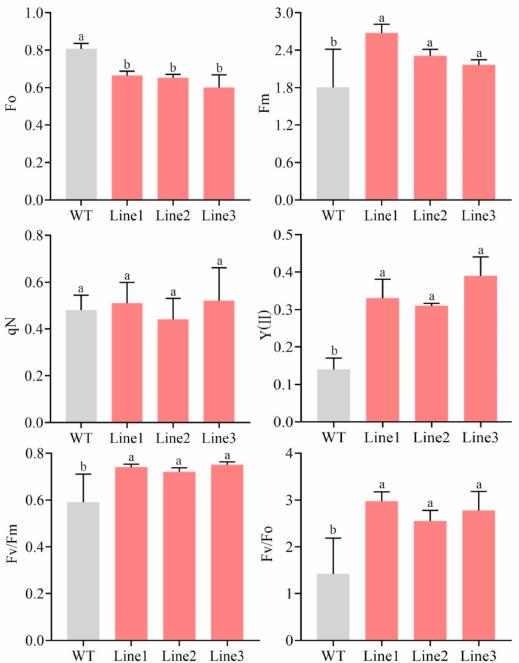
Figure 10. Chlorophyll fluorescence parameters of WT and transgenic lines under drought stress. Tobacco plants were stressed by drought for 10 days. The values represent the mean ± SD, and different letters indicate significant differences according to Duncan’s multiple range test ( p <